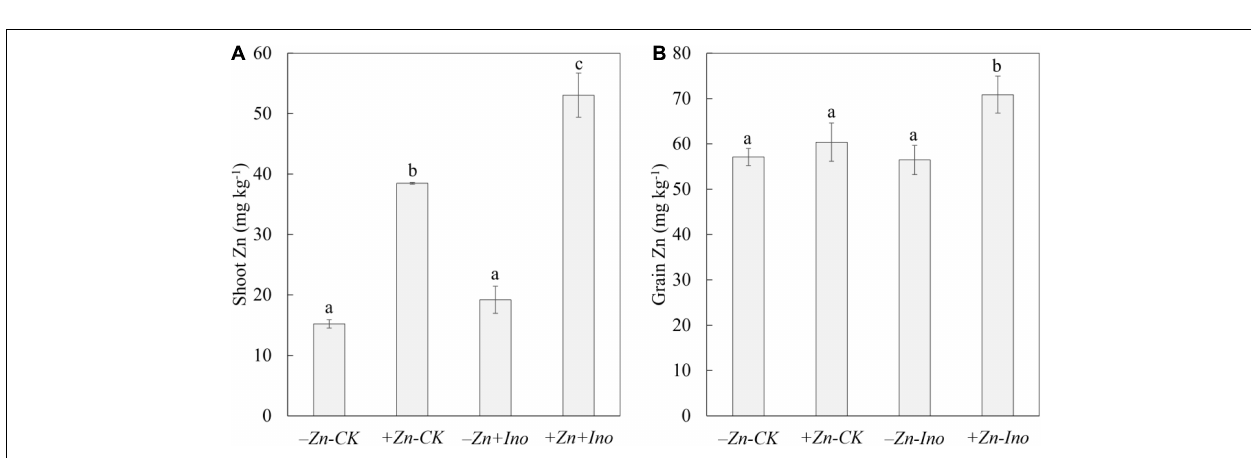
FIGURE 1 | Grain yield (A) and plant biomass (B) of wheat treated with different foliar fertilizers. Data points and error bars represent means and SE of four replicates. Different letters denote significant differences ( p < 0.05, n = 4).